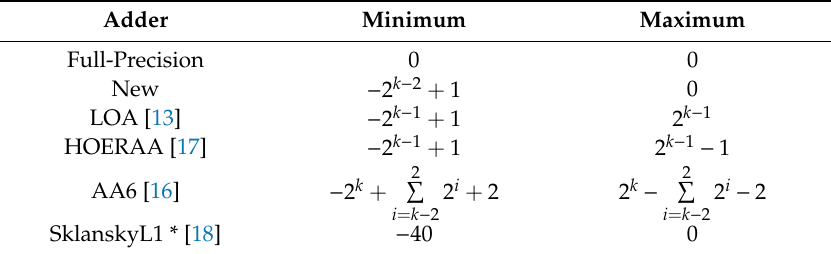
Figure 5. Error distributions related to: ( a ) k = 4; ( b ) k = 6. Table 6. Minimum and maximum errors.